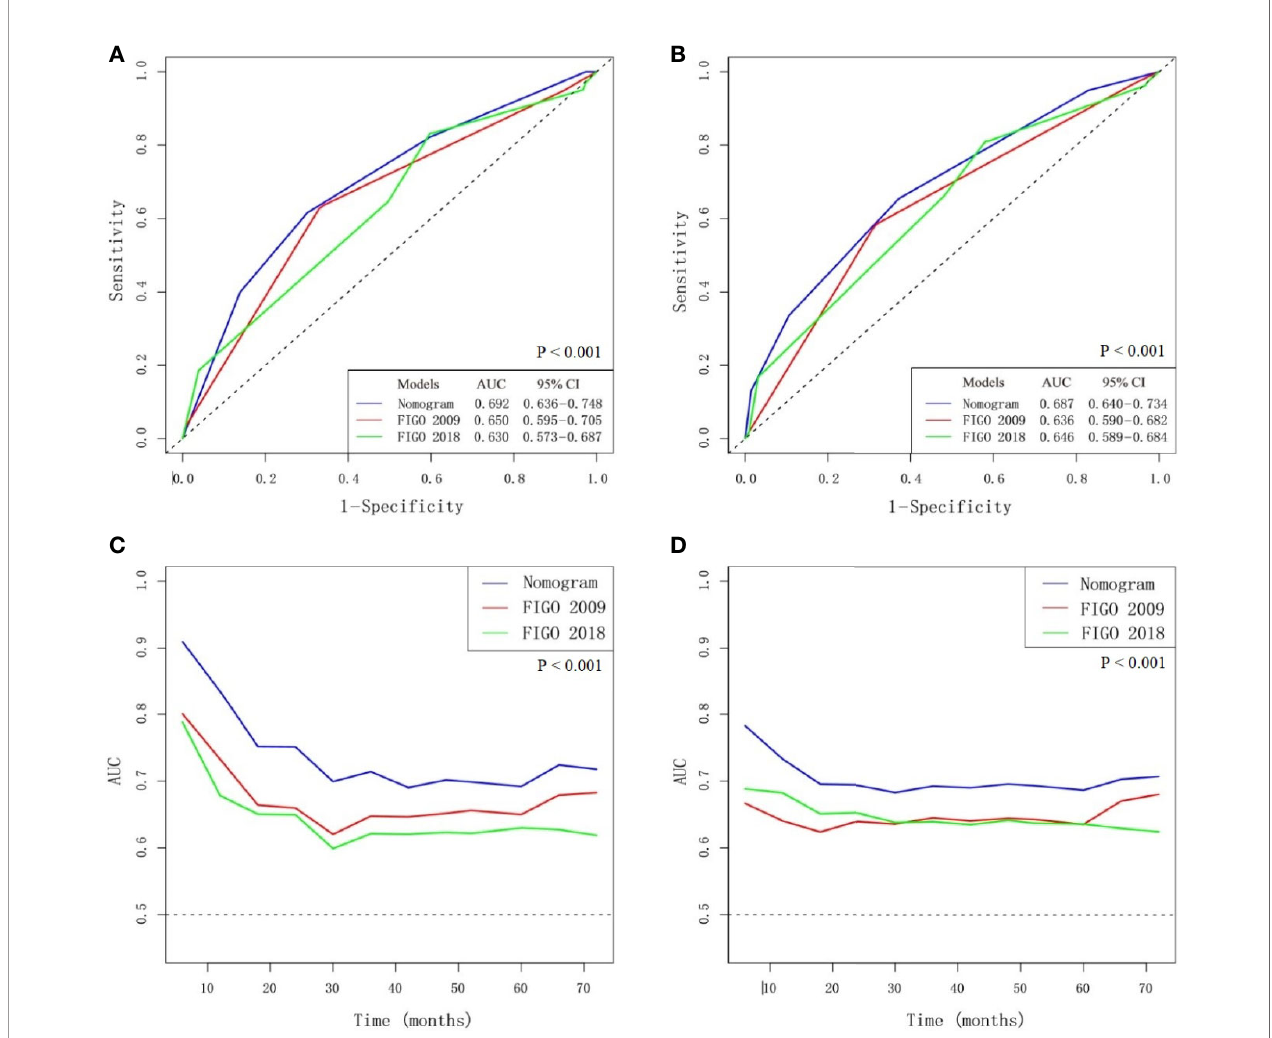
FIGURE 6 | Comparison of nomogram and FIGO staging system. (A) AUC for predicting 5-year overall survival (OS). (B) AUC for predicting 5-year progression-free survival (PFS). (C) The time-dependent AUC between 6 and 72 months for OS. (D) The time-dependent AUC between 6 and 72 months for